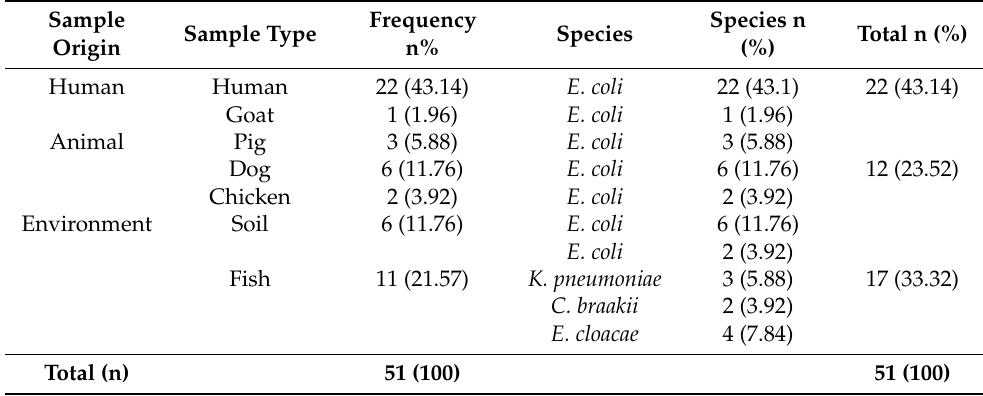
Table 1. Bacteria species distributed among donor isolates of human, animal and environment.